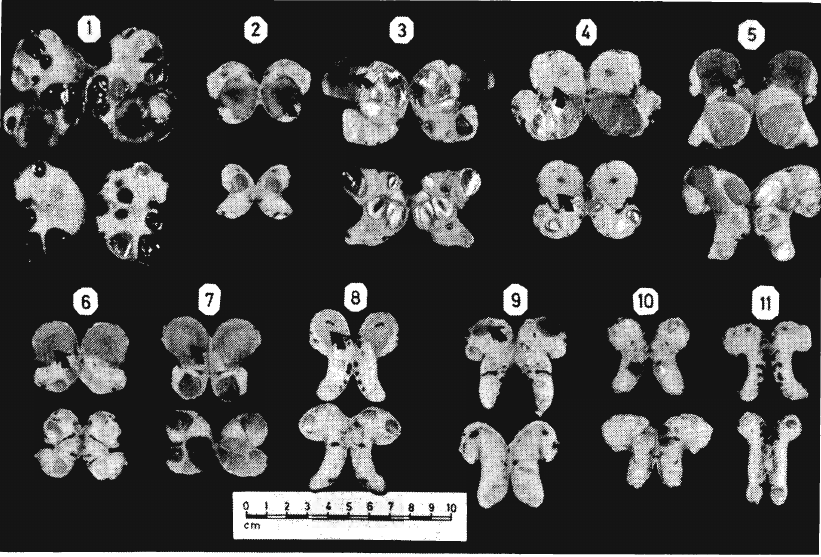
Fig. 8. Eleven pairs of ovaries from Burchell's zebra mares at various stages of pregnancy. The ovaries have been cut from their free to attached borders and opened out to illustrate the internal appearance. All ovarian pairs are arranged vertically with the tubal extremity upper most. On the photograph the coagulated liquor folliculi of most follicles appears as a shiny surface, while the corpora lutea are duller, one half of each being pin-pointed by a small black arrow. Legend: (1) = 15 days pregnant. Notice many small follicles and the large developing corpus luteum with blood stained liquor folliculi still in the centre. (2) = 20 days pregnant. At this stage the corpus luteum of pregnancy has already reached its maximum size and there was a reduction in follicular activity; (3) = 74 days. At this stage there was an increase in follicular activity while the corpus luteum of pregnancy was gradually regressing; (4) = 102 days. In this specimen as in (5), follicular activity is still obvious. It also has two corpora lutea both being approximately the same size; (5) = 113 days; (6) = 135 days. This specimen shows reduced follicular activity in both ovaries, while a luteal scar (corpus albicans) is clearly visible as a dark narrow streak